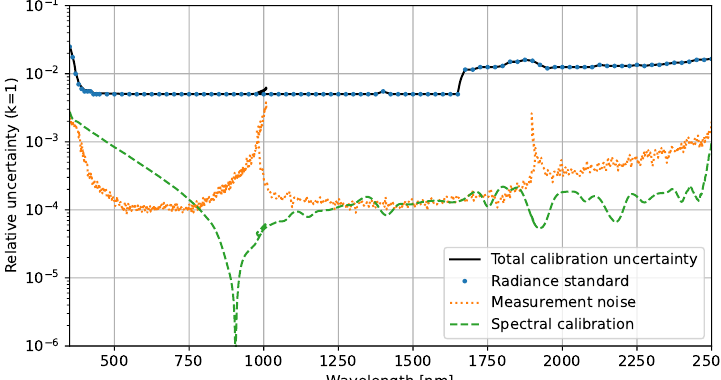
Figure 8. Contributions to the relative uncertainty in the radiometric calibration of the spectro- radiometer. The DLR radiance standard (RASTA) has the most significant uncertainty over the spectroradiometer’s wavelength range.